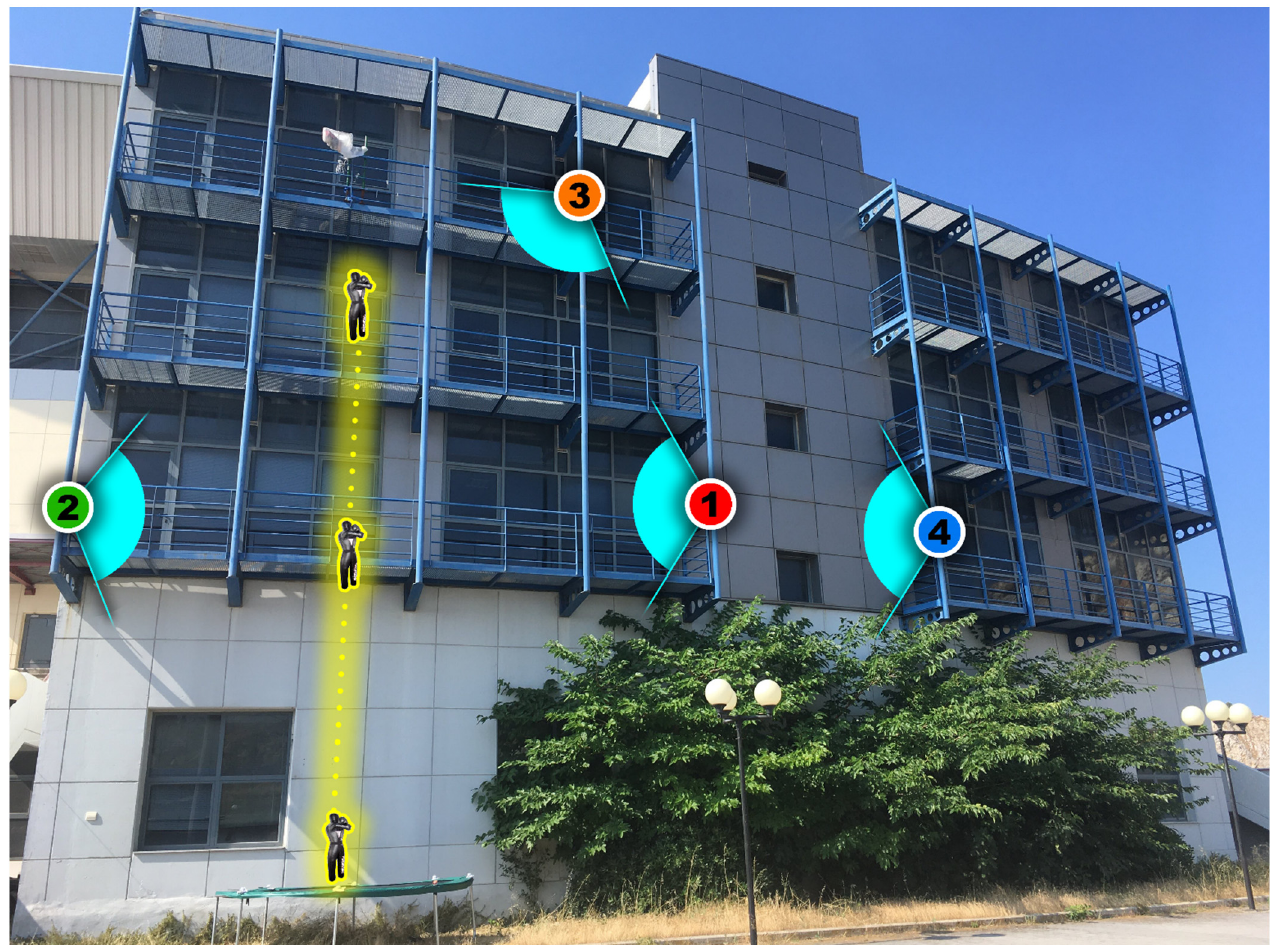
Figure 6. The four different locations of the building (red, green, orange, and blue) where the RGB camera was placed throughout the data acquisition process regarding the freefall (yellow) of the human dummy (as presented in [15]).